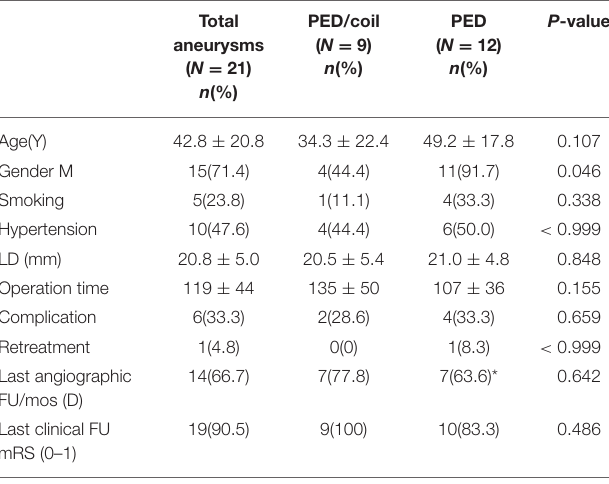
TABLE 3 | Statistical assessment of parameters of the two